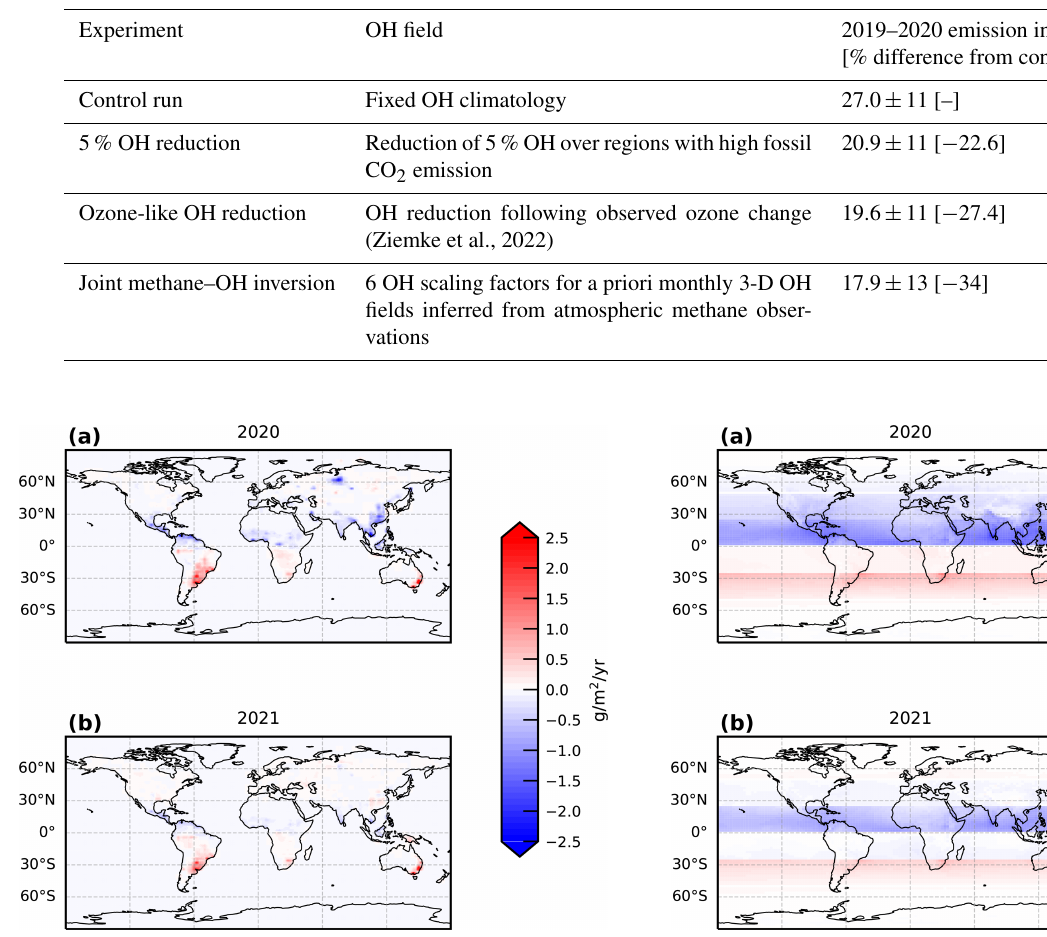
Figure 6. Annual mean difference of a posteriori methane emis- sions between the control inversion that uses OH climatology and the joint OH–flux inversion that estimates OH scaling factors for (a) 2020 and (b) 2021.